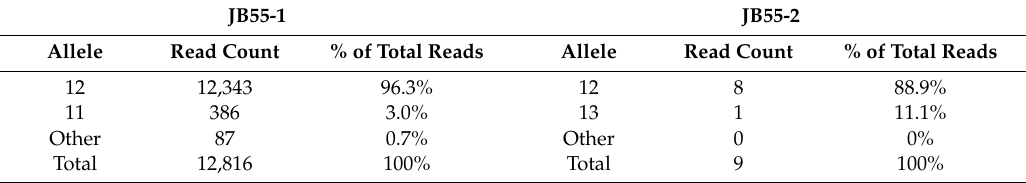
Table 3. DYS438 alleles obtained from Illumina sequencing of the Yfiler amplification product from the two JB55 DNA extracts. The stutter product with the highest read count is also shown (11 for JB55-1 and 13 for